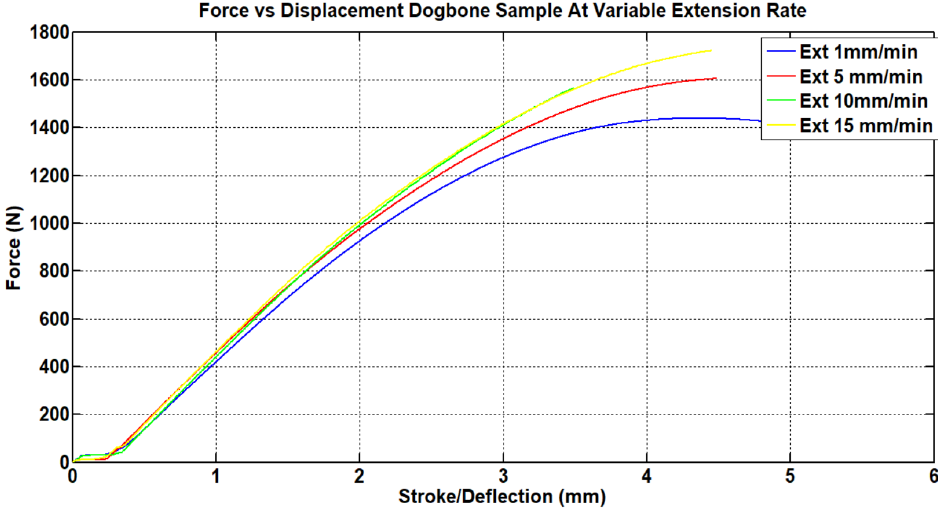
Figure 7. Load vs. displacement graph for acrylic dog-bone samples.